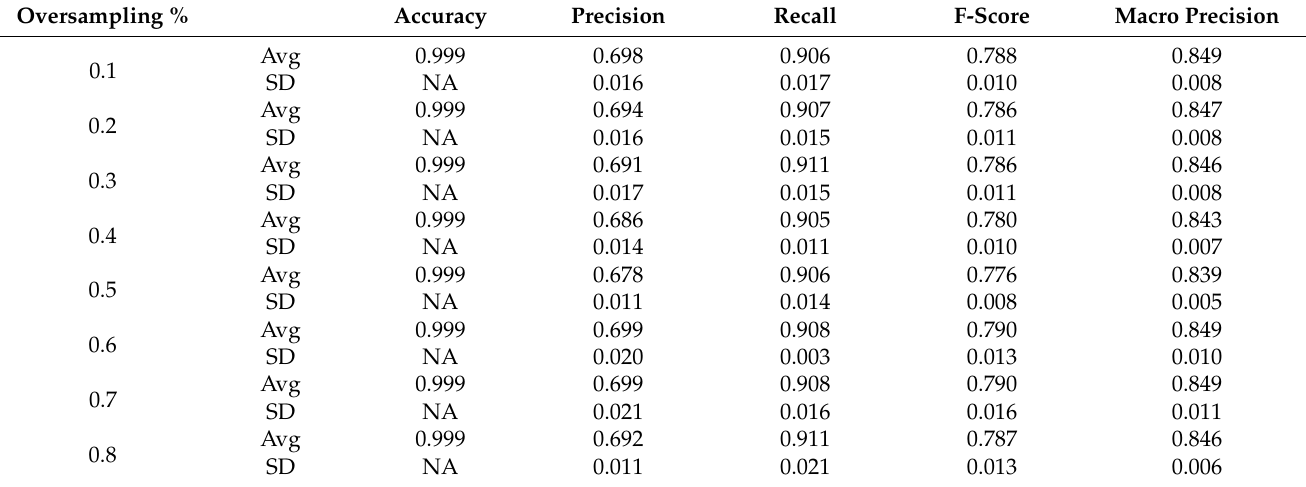
Table 17. UNSW-NB15: Shellcode—classification results for random undersampling after